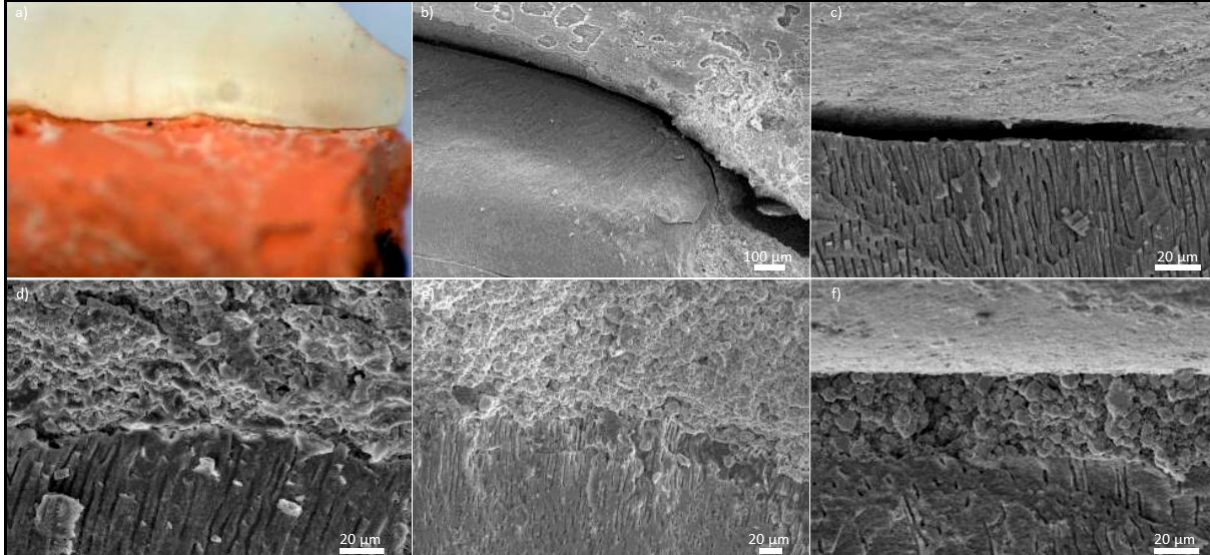
Figure 18. View: ( a – c ) leaks on the border of the sealant and dentin of the root canal filled with the thermoplastic conden- sation method: ( a ) in the near-crown section, viewed with LSM; ( b ) in the anatomical cavity of the central canal, viewed with SEM; ( c ) in the middle section, viewed with SEM. ( d – f ) Tight connections of material based on gutta-percha filled by cold condensation, covered with an intermediate layer of sealant and root canal dentin, viewed with SEM.